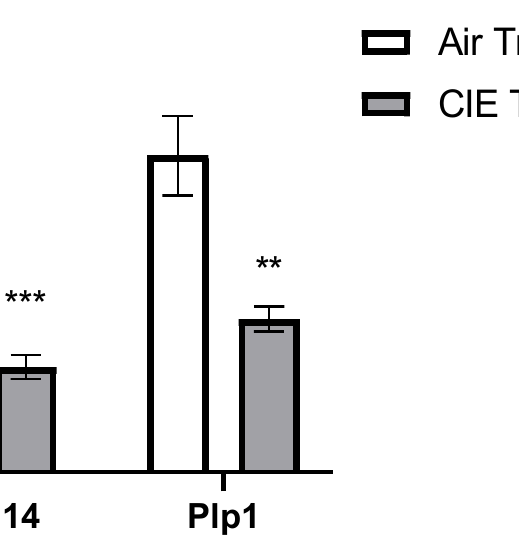
Figure 2. qRT-PCR validation of two cell type-specific DEGs, Mmp14 (astrocytes) and Plp1 (oligodendrocytes), differentially expressed at FDR < 5%. *** p < 0.001; ** p < 0.01 based on Student’s t - test.